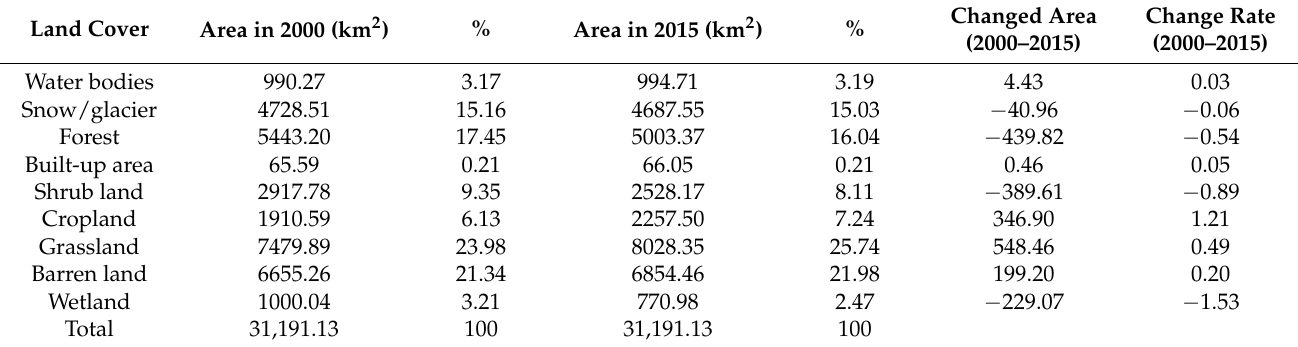
Figure 2. The distribution of different land cover types in KSL in 2000 and 2015. Table 3. Land use and land cover (LULC) in the KSL during the period